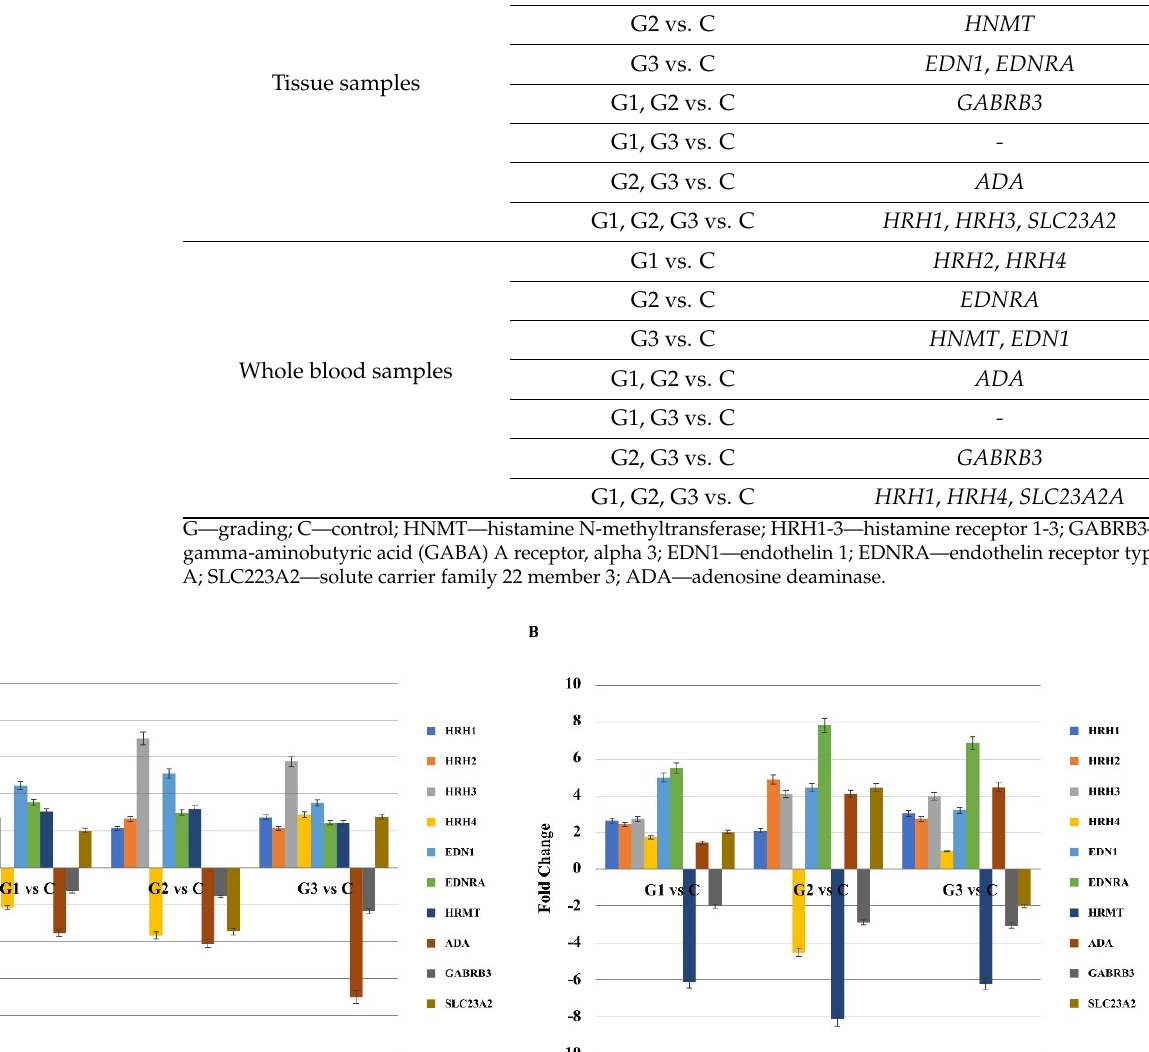
Table 6. Expression profile of miR-33a-5p, miR-3915, miR-1-3p, miR-575, and miR-27a-5p in endo- metrial tissue and whole blood of patients with endometrial cancer, compared to the control. mRNA miRNA